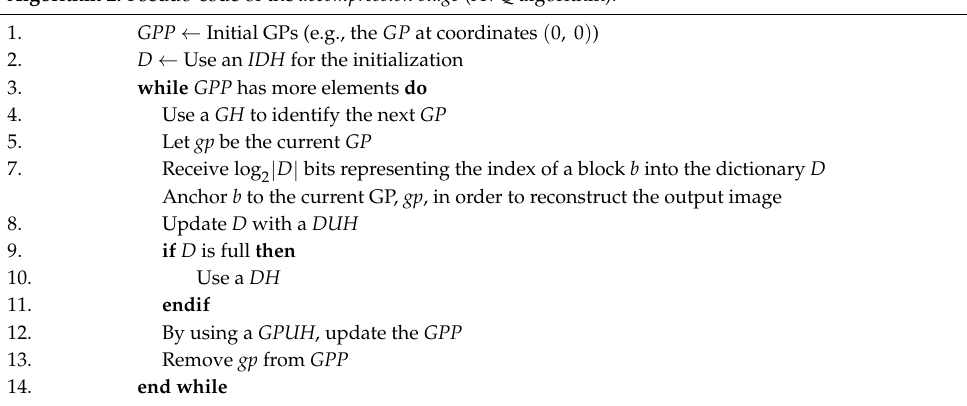
Algorithm 2. Pseudo-code of the decompression stage (AVQ algorithm).